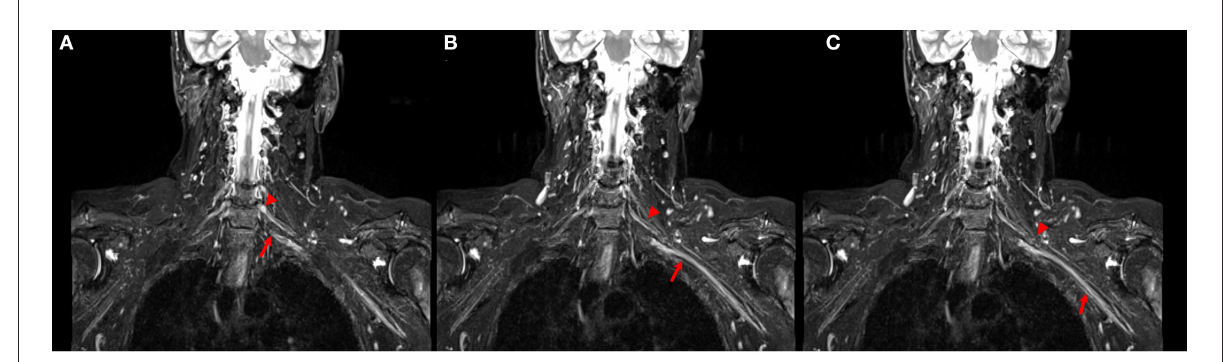
FIGURE3 (A–C) Coronal STIR images of the brachial plexus. Different size and signal intensity are shown between the right and the left side of C6 (arrow head) and C7 (arrow) roots in proximal (A, B) and distal (C)